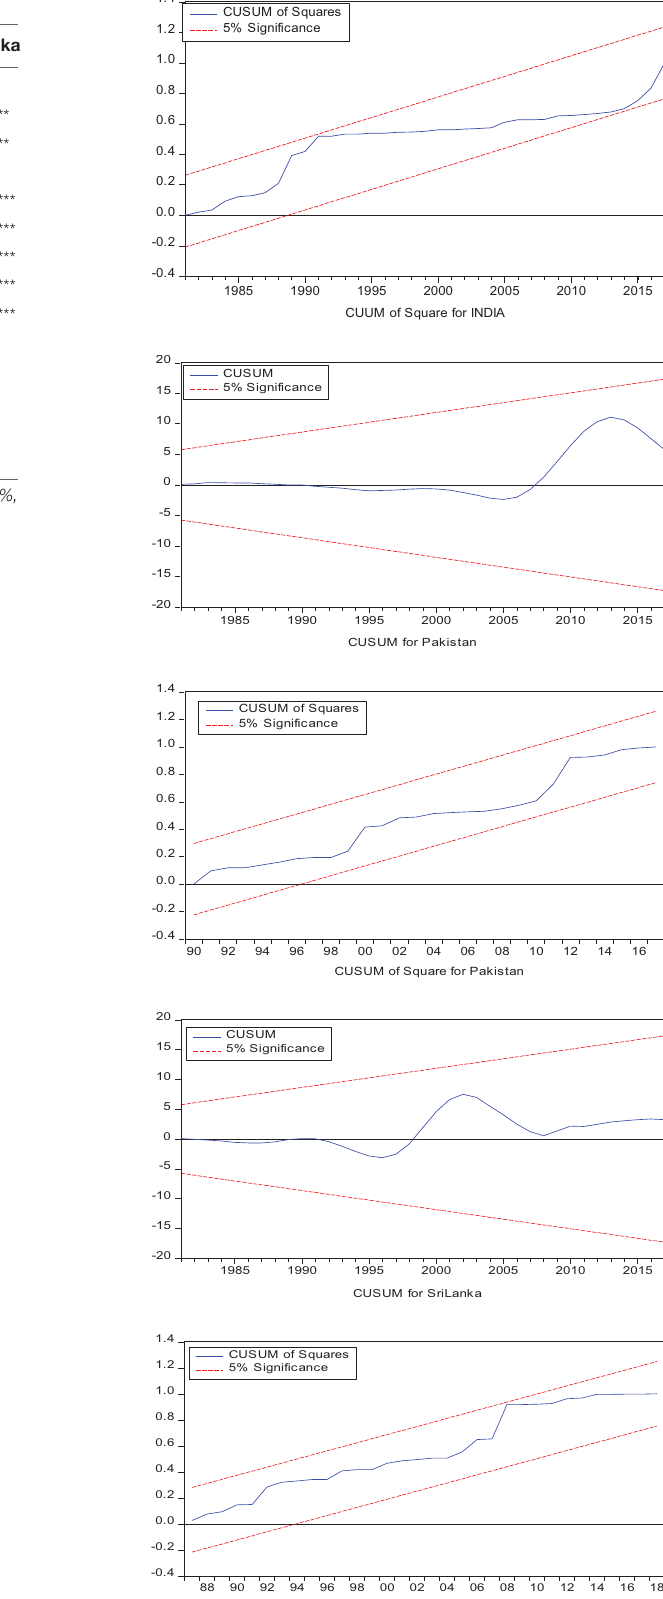
TABLE 6 | ARDL cointegration